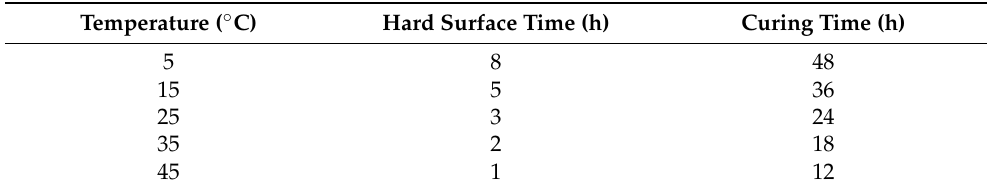
Table 4. Hard surface time and curing time of GIS–I adhesives at different temperatures.